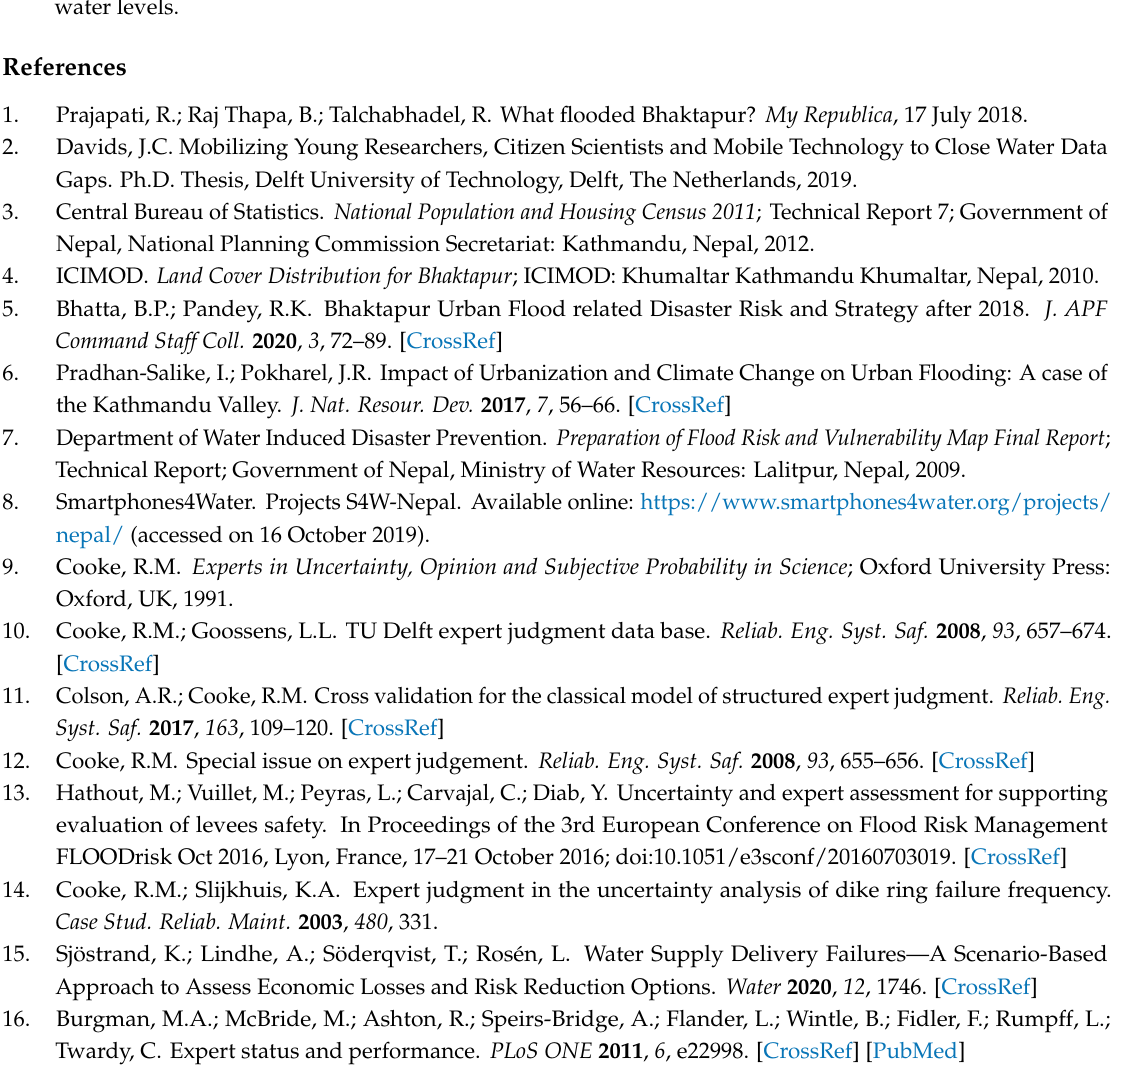
Figure A3. The probability density function according to the GEV based on the 95% quantiles of the water